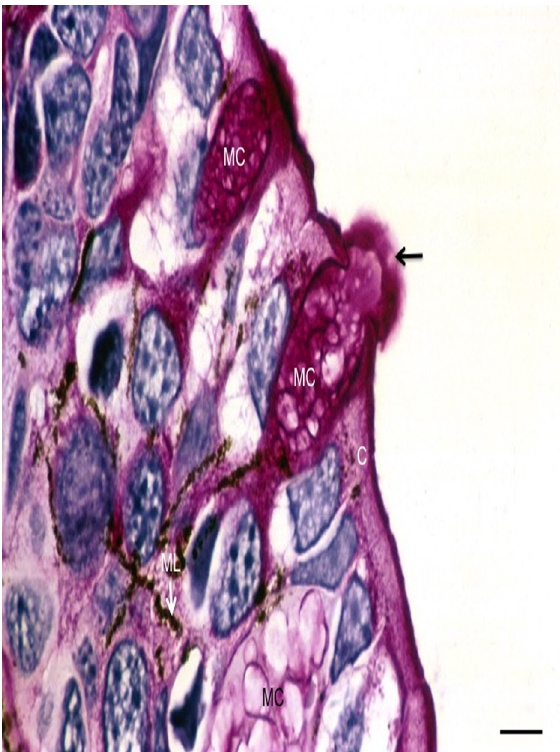
Figure 5 - Skin of abdominal region. of L. paradoxa epidermis with marked cellular activity. Melanin can be observed in the epidermis (arrow) at the surface of an electroreceptor (er). In the dermis, melanophores with “dendritic” extensions (M) can be observed. Cajal gold sublimate. Bar: 50